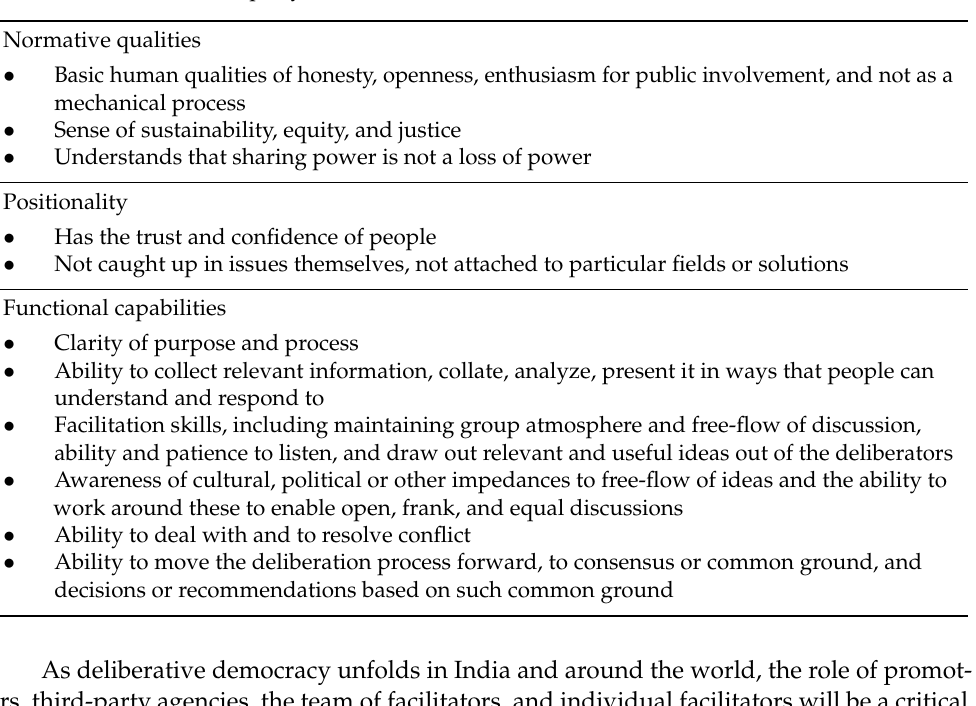
Table 2. Qualities of third-party